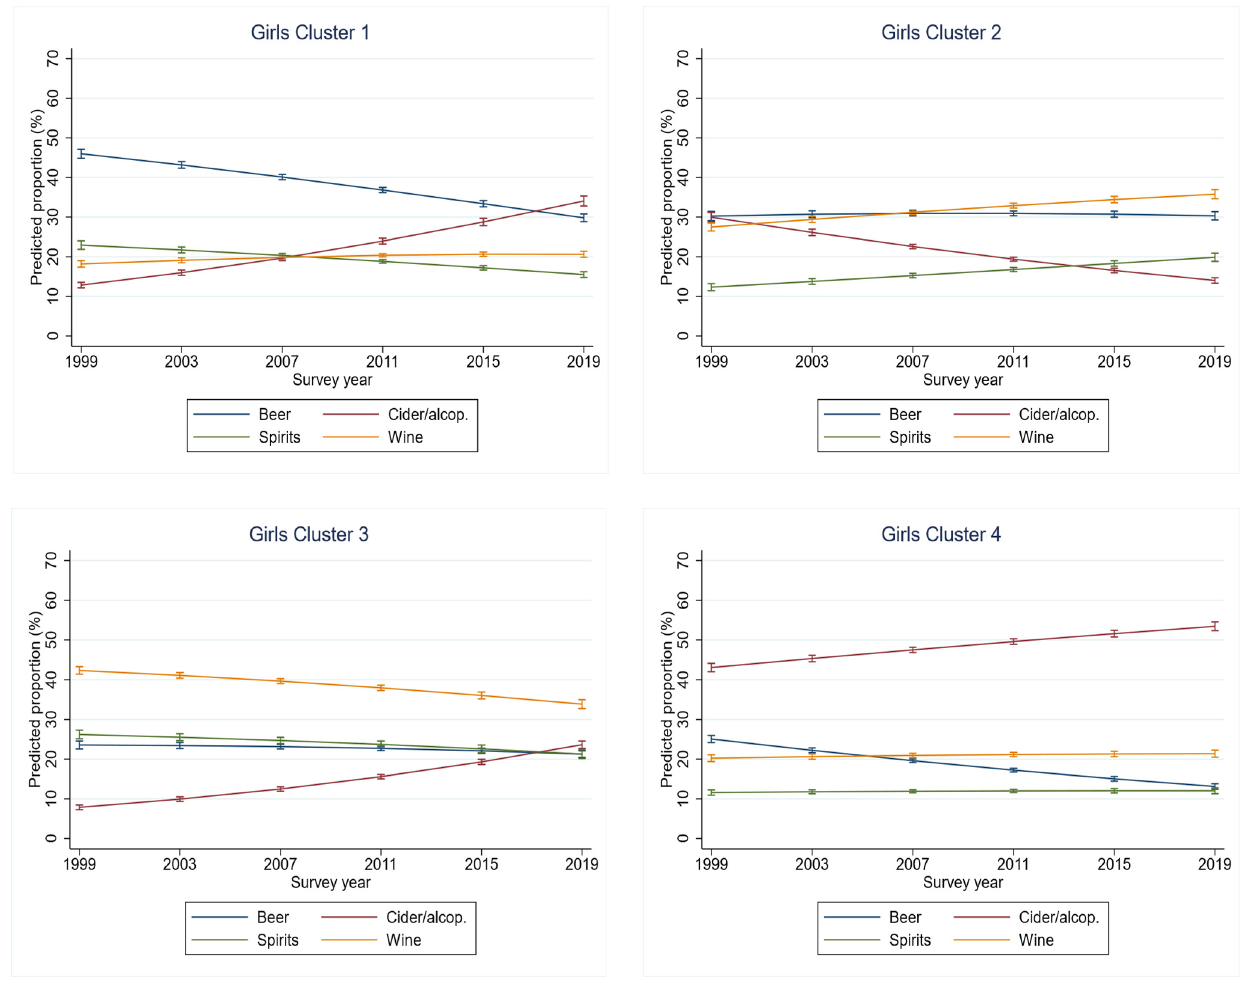
Figure 1. Clusters of trends in distribution of beverages consumed on most recent drinking occasions for girls.